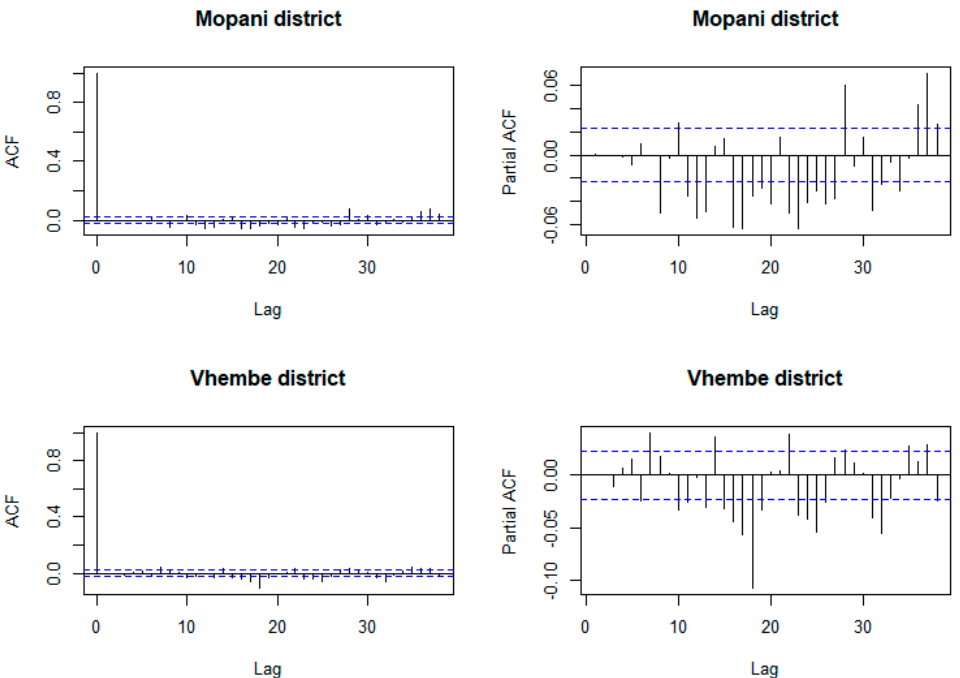
Figure 5. Plot of autocorrelation function and partial autocorrelation function of residuals of ZINB model for Mopani and Vhembe district municipalities.